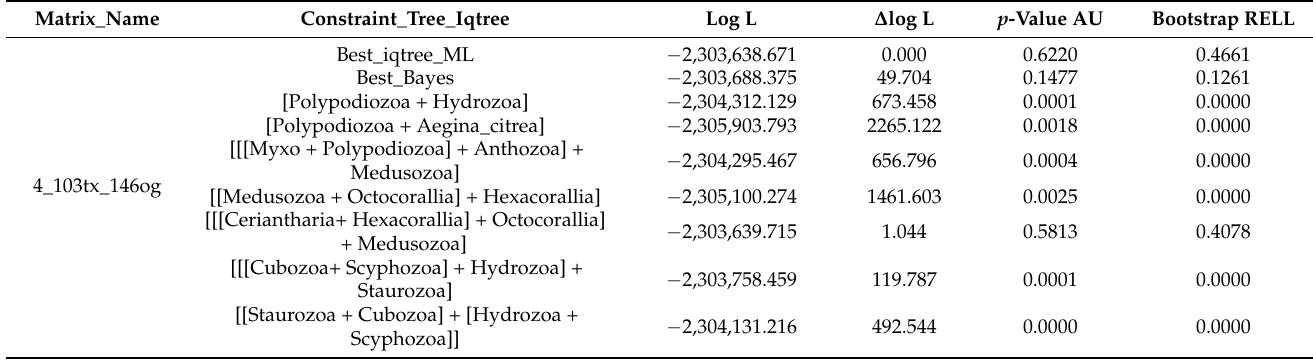
Table 2. Approximately unbiased test of the cnidarian phylogeny. Each tree was loosely constrained with the hypothetical groupings and optimized under LG + Γ 4 + FMIX (empirical, C20) in IQ-tree using the 146-gene (51,598 sites) data set. The optimized trees were compared using the approximately unbiased test with 10,000 RELL bootstrap replicates. Maximum log-likelihoods of each constraint and their differences from the optimal ML tree are listed. The hypotheses within the 95% confidence interval that could not be rejected are where p ≤ 0.05. POLYPODIOZOA, Polypodium hydriforme